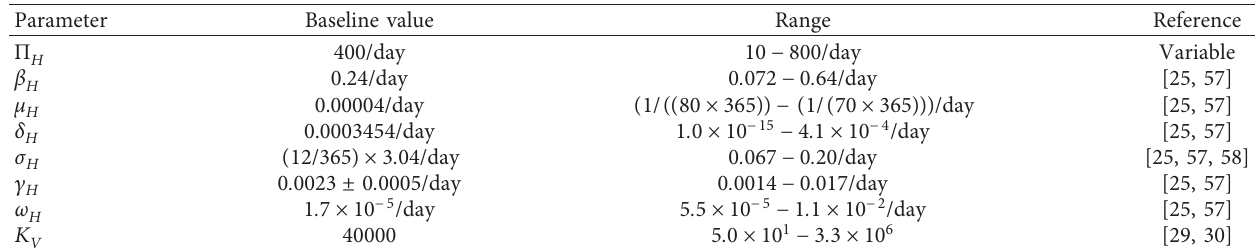
Table 2: Values and ranges of the temperature-independent parameters of the model (2). Parameter